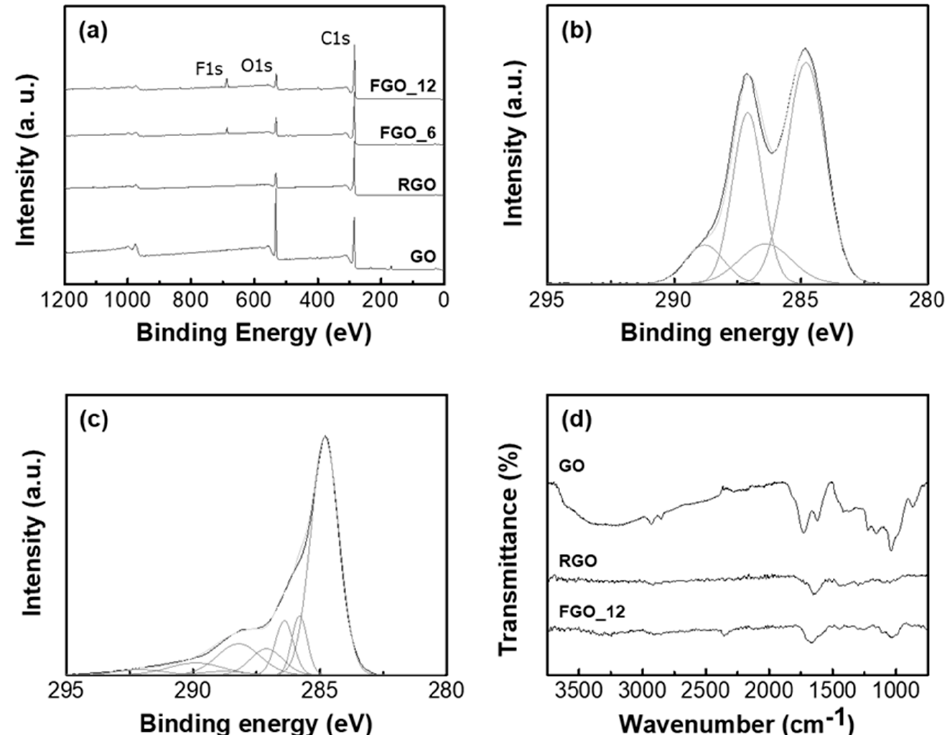
Figure 1. ( a ) X-ray Photoelectron Spectroscopy (XPS) spectra of graphene oxide (GO), reduced graphene oxide (RGO), fluorinated graphene oxide (FGO) _6 and FGO_12. Deconvoluted C1s XPS spectra of ( b ) GO and ( c ) FGO_12. ( d ) Fourier transform infrared (FT-IR) spectra of GO, RGO and FGO_12. Table 1. Atomic percentages of GO, RGO, FGO_6, FGO_12 and FGO_24.